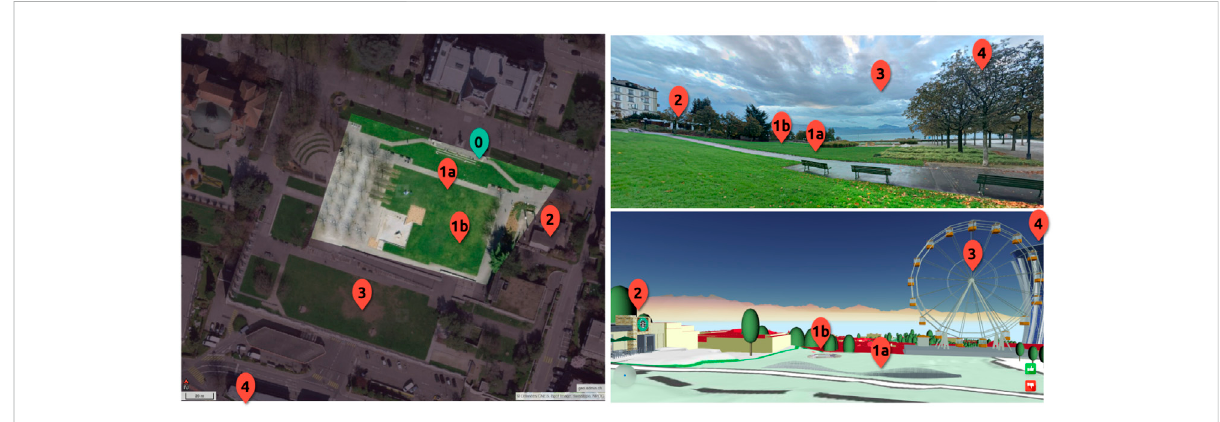
FIGURE 3 Illustration of the study area with the location of the project ’ s objects. The top view of the study area shows a lighter surface, which represents theexplorable areaduring theusabilitystudy.Ontheright, thestudy areaispresentedfrom a fi rst-person perspective witharealistic view (right-top) and a view from the VGE